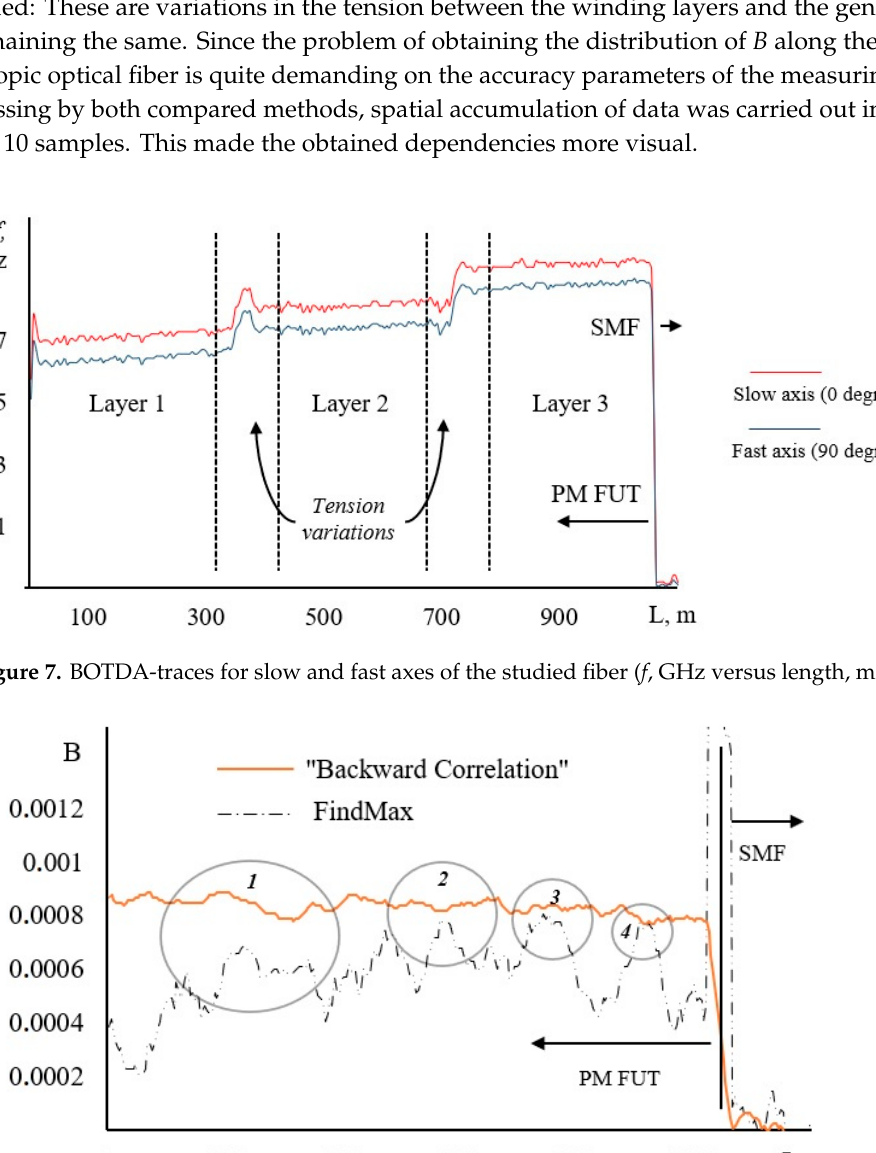
Figure 6. A schematic fragment of the studied fiber (FUT) cross-section on the transport coil.